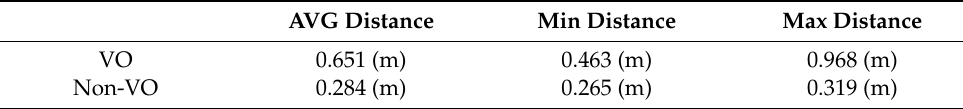
Table 4. Comparison of safe navigation